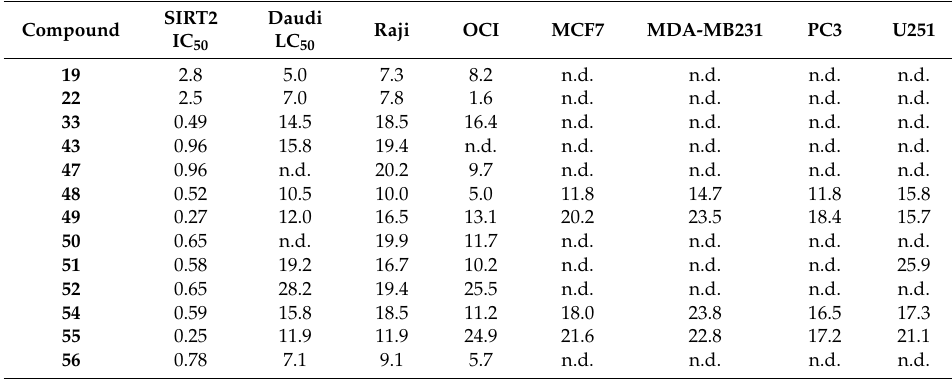
Table 5. In vitro SIRT2 inhibitory activity (IC 50 ) and cytotoxicity (LC 50 ) of SIRT2 inhibitors in B-cell lymphoma and other cancer cell lines.